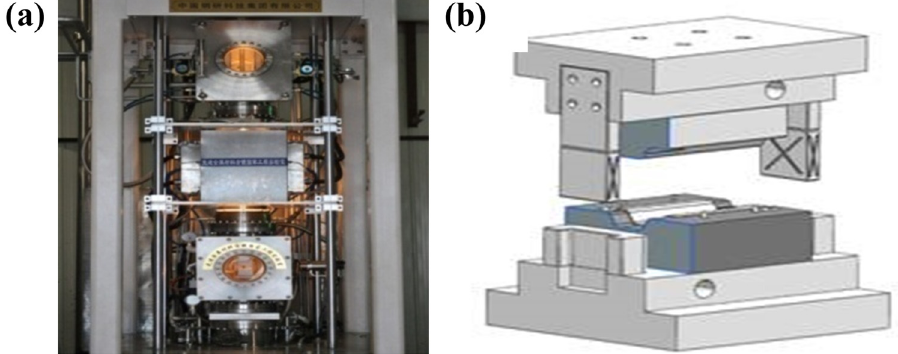
Figure 1: Hot - dip simulator machine and hot forming tooling: ( a ) hot - dip simulator machine and ( b ) hot forming